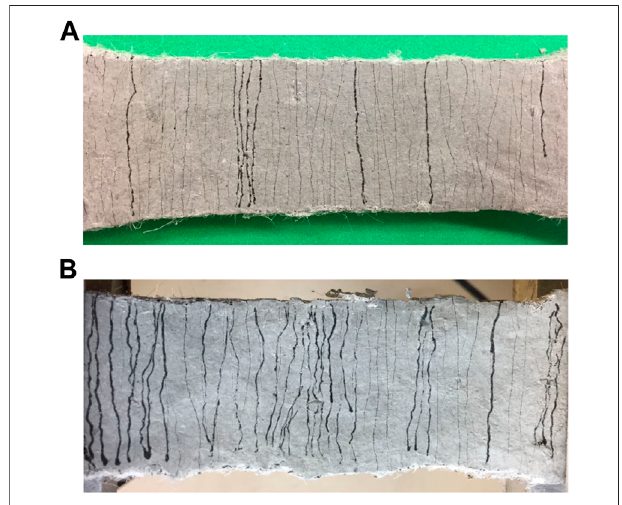
FIGURE 13 | Comparison of crack pattern for CR2-0.4 specimens beforeandaftercuringandreloading: (A) 0.5%pre-tensilestrainand (B) 2.0% pre-tensile